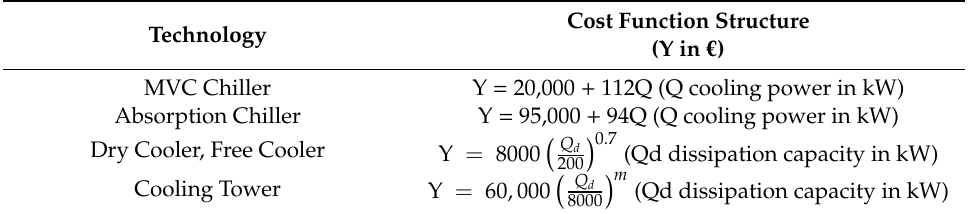
Table 3. Equipment cost functions used in this